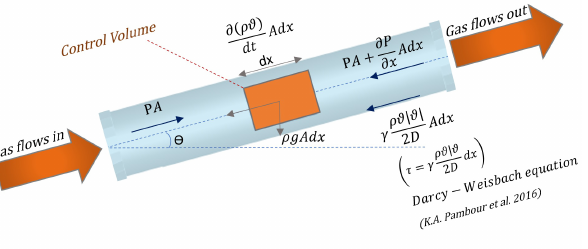
Figure 3. Effective forces on a specific volume of gas flow through a pipeline